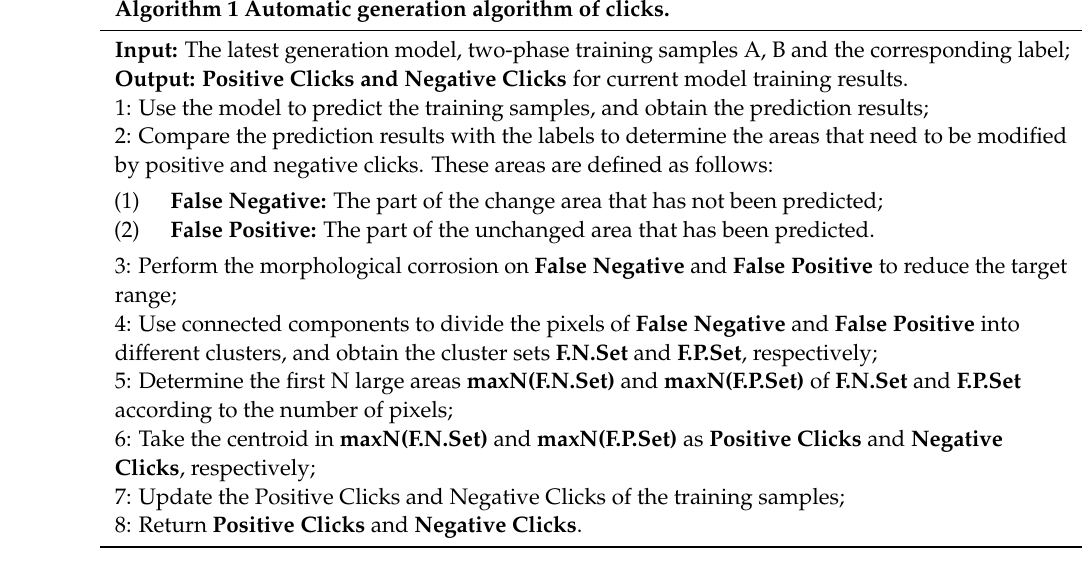
Algorithm 1 Automatic generation algorithm of